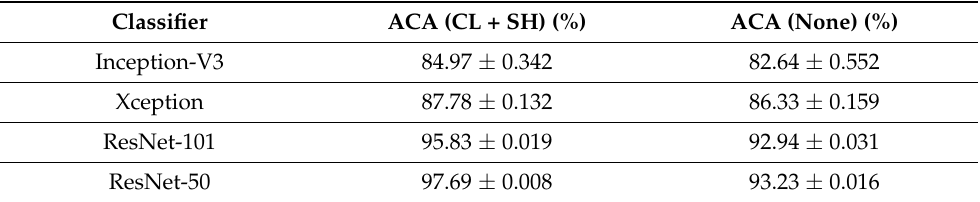
Table 5. Performance evaluation in terms of ACA by deep learning classifiers in combination with GAN-based technique when CL + SH is used for